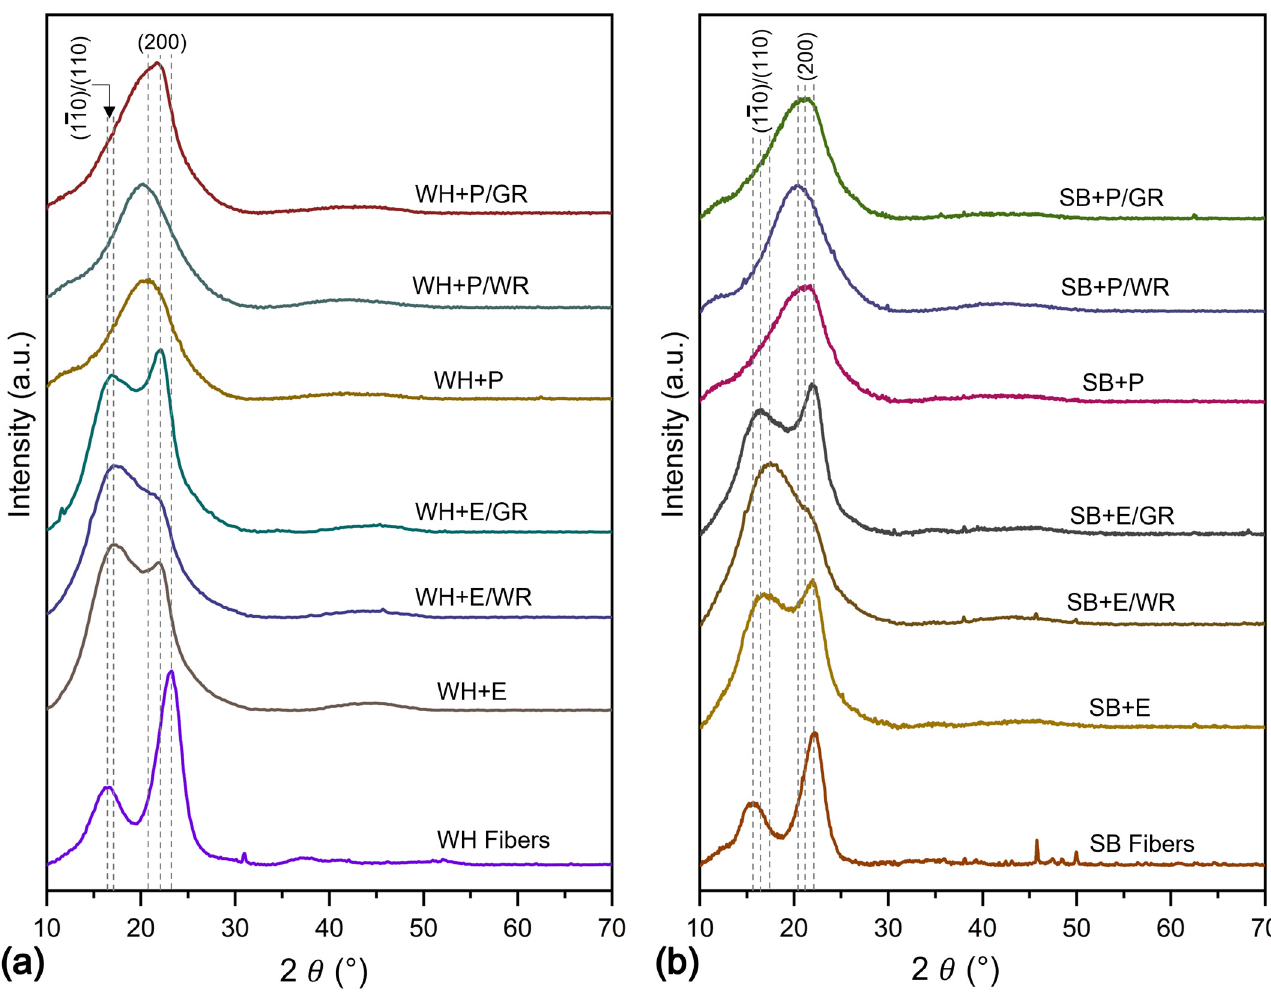
Figure 6. ( a ) XRD spectrum of standard (WH + E, WH + P), water-repellent-treated (WH + E/WR, WH + P/WR) and gamma-irradiated (WH + E/GR, WH + P/GR) water hyacinth composites, and ( b ) EDX spectrum of standard (SB + E, SB + P), alkali-treated (SB + E/WR, SB + P/WR) and gamma- irradiated (SB + E/GR, SB + P/GR) sugarcane bagasse composites.